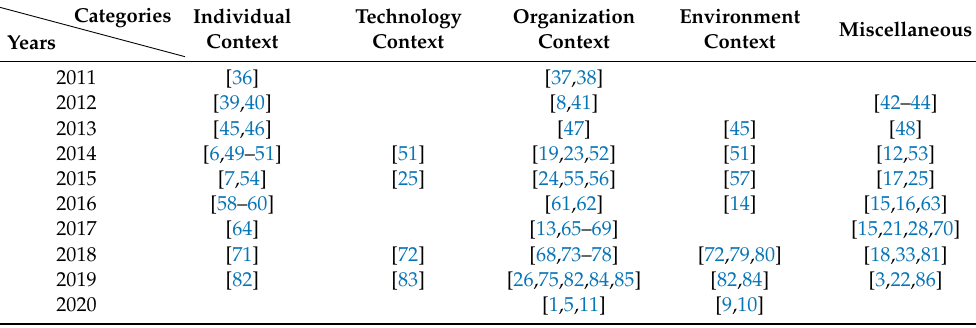
Figure 2. Publications distribution by years from 2011 to 2020. Table 4. Distribution of studies into dimensions by year of publication.